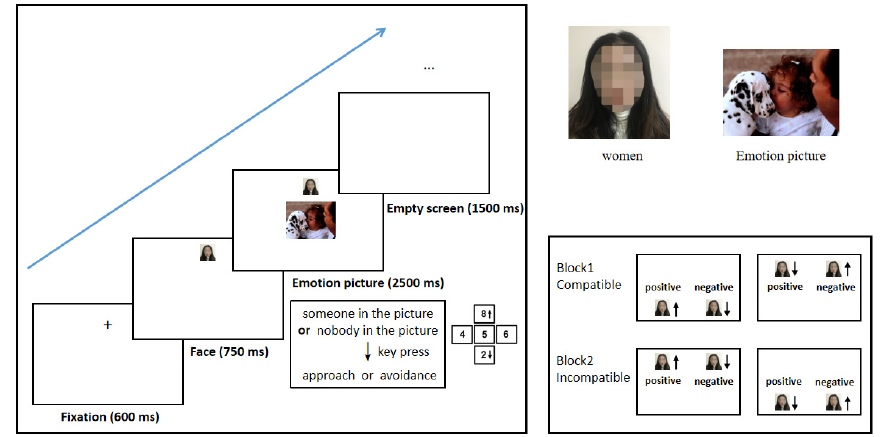
Figure 2. Experimental procedure in Experiment 2. The procedure used was similar to that for